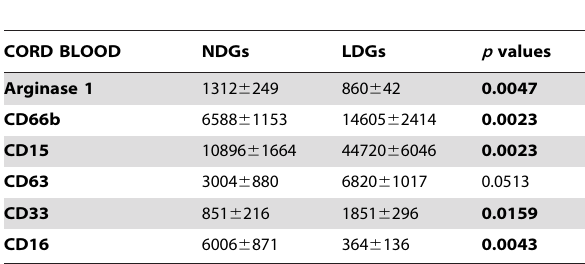
Table 1. Expression levels of arginase and phenotypic markers of NDGs and LDGs in cord